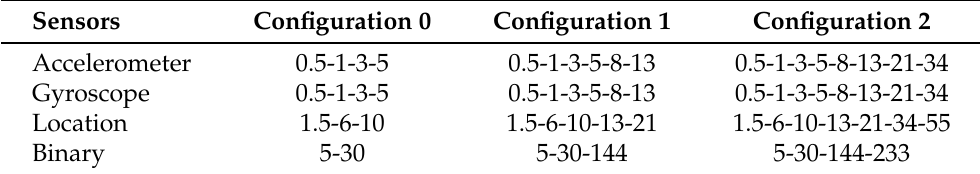
Table 7. Window sizes from the different